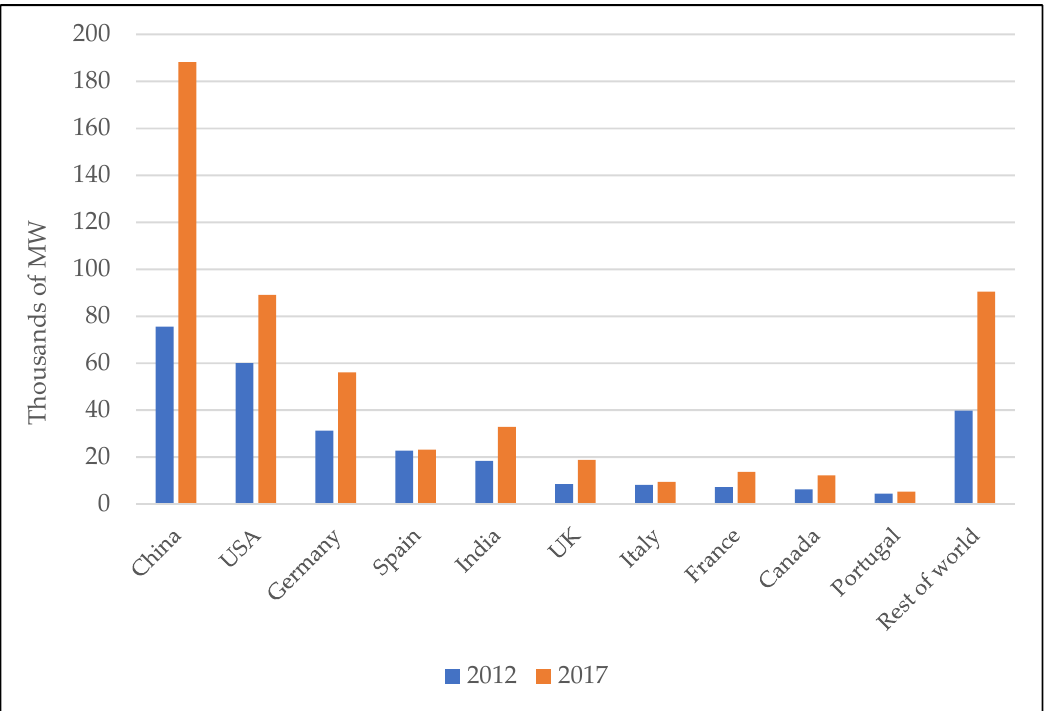
Figure 1. Contribution of renewable energies to energy supply as a percentage of total primary energy supply. (Data source: https://data.oecd.org/energy/electricity-generation.htm, (Accessed on 11 October 2021).